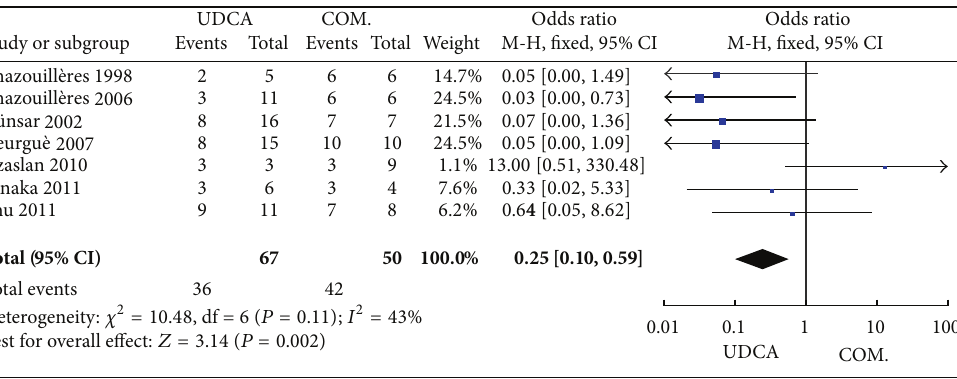
Figure 4: IgG and IgM levels in patients treated with monotherapy versus combination therapy for PBC-AIH.